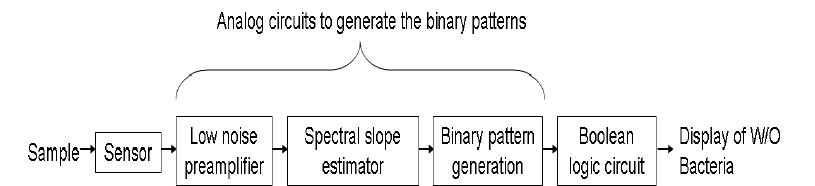
Figure 2. Major building blocks of the low-power sensing